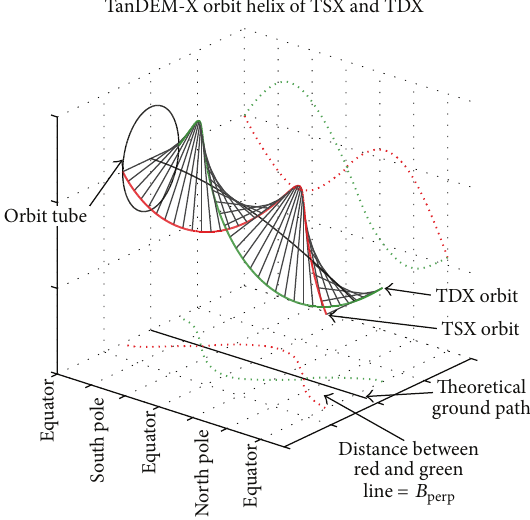
Figure 2: TerraSAR-X (red) and TanDEM-X (green) orbit constellation—close formation helix-like orbit. X -axis is one revolution around the